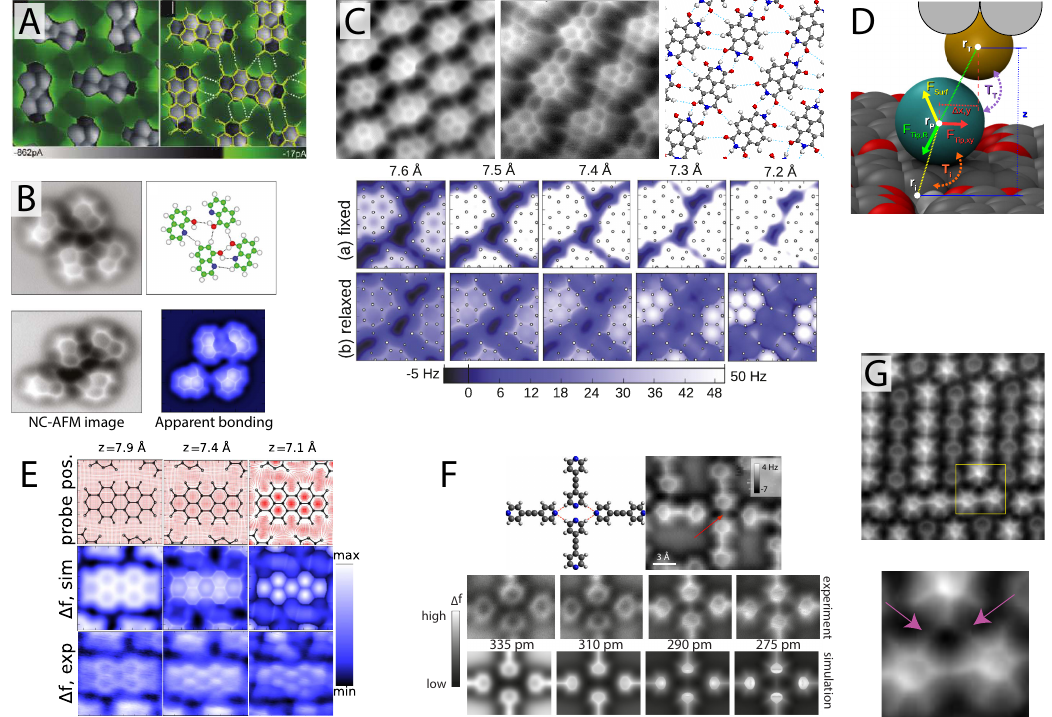
Figure 3. Intermolecular artefacts in hydrogen bonded assemblies. ( A ) First ever observation of apparent intermolecular bonds using scanning probe microscopy (SPM) observed via the STHM technique (reprinted with permission from [58], copyright 2010 by the American Chemical Society); ( B ) CO-mediated NC-AFM image of 8-hydroxyquinoline (8-hq) assembly exhibiting features in the locations of hydrogen bonding (from [61], reprinted with permission from AAAS) shown with simulated data (bottom right) [59]; ( C ) NC-AFM image revealing apparent intermolecular features in hydrogen bonded assemblies of NTCDI [40] also shown with simulated data confirming the apparent nature of the intermolecular features [59]; ( D ) Schematic of the flexible tip model used to simulate images of artificial intermolecular bonding [59]; ( E ) Experimental and simualted NC-AFM images of a PTCDA island shown with the simulated CO probe position [59]; ( F ) Experimental and simulated NC-AFM images of hydrogen bonded bis(para-pyridyl)acetylene (BPPA) molecules revealing apparent intermolecular bonds even where none are present (see red arrow) (reprinted with permission from [62], copyright 2014 by the American Physical Society); ( G ) NC-AFM image of apparent halogen bonding between the Fluorine atoms (see pink arrows in zoom of area marked with a yellow box) of three BPEPE-F18 (fluoro-substituted phenyleneethynylene) molecules (reprinted with permission from [63], copyright 2015 by the American Chemical Society). All figures from [59] reprinted with permission, copyright 2014 by the American Physical